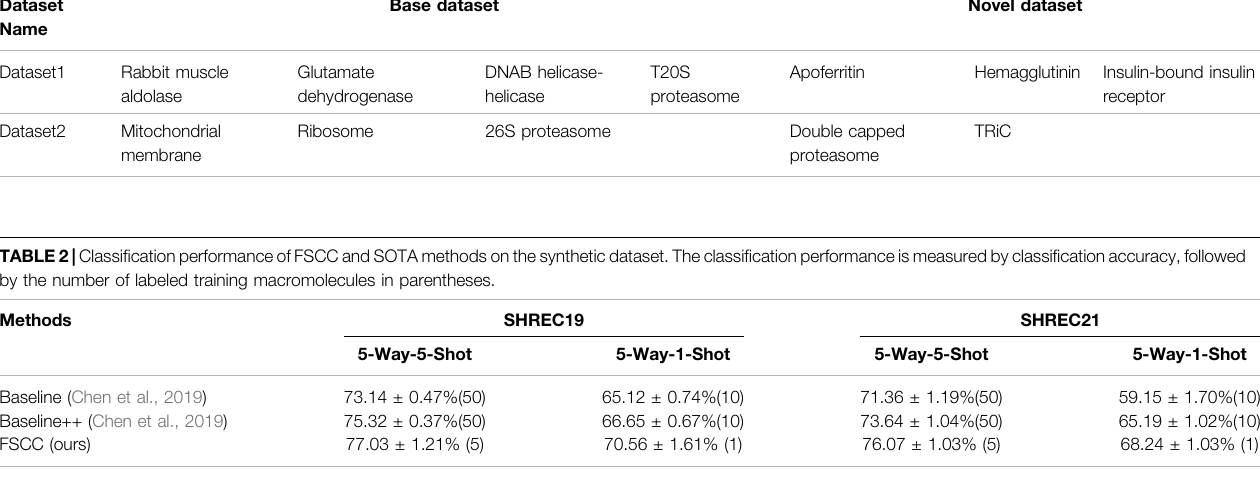
TABLE1| Macromolecularstructurescoveredinrealdatasets.The fi rstlineshowsthemacromolecularstructuresinDataset1.Thesecondlinemacromolecularstructuresin Dataset2. Dataset Name